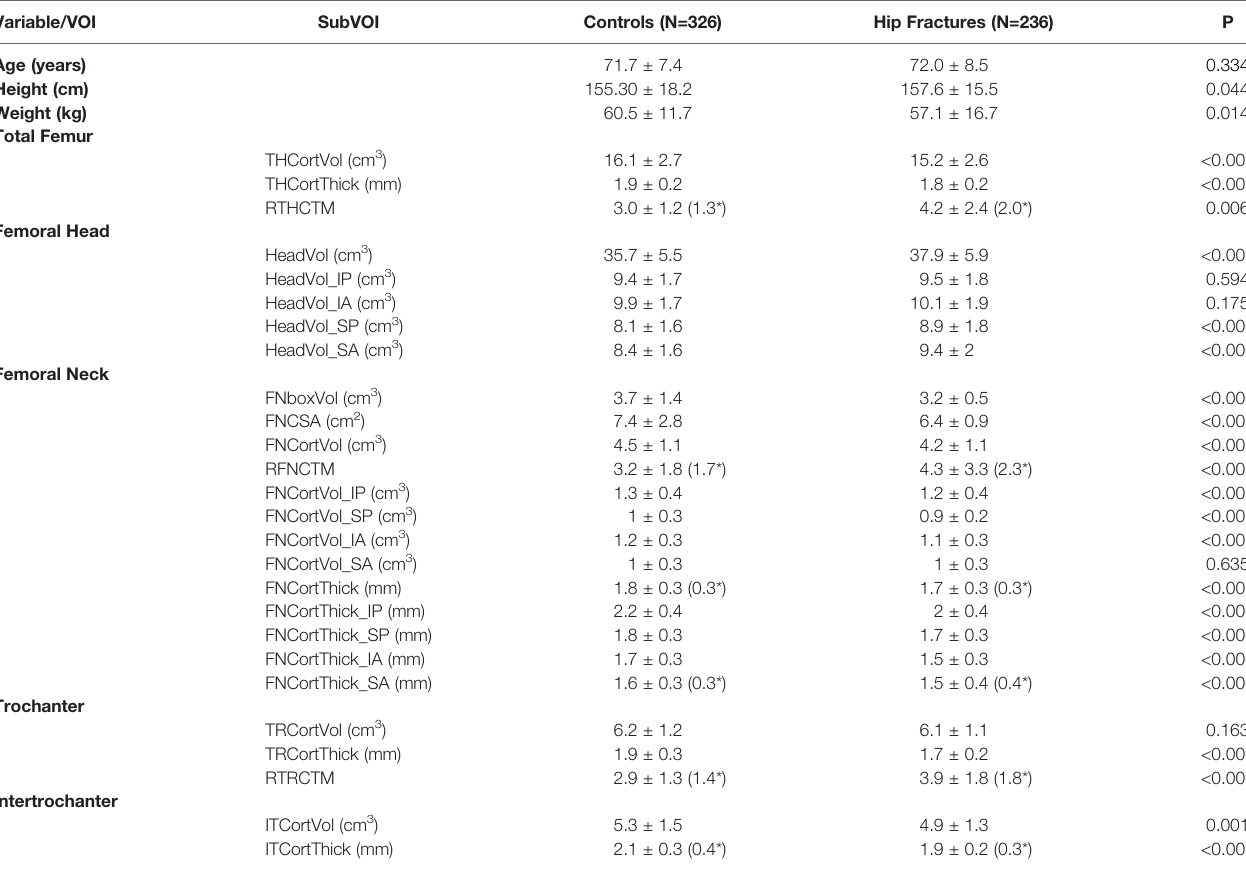
TABLE 1 | Characteristics of participants.